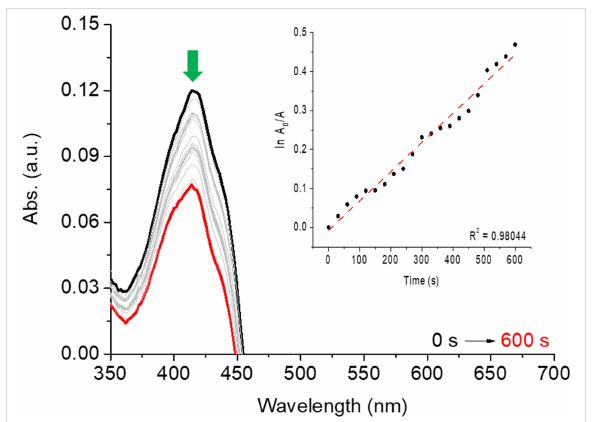
Figure 7: DPBF photooxidation assays by red-light irradiation with diode laser ( λ = 660 nm) in the presence of quinoline 3bb (R = Ph, R 1 = 5-NEt 2 ). The inset shows the first-order kinetic profile.